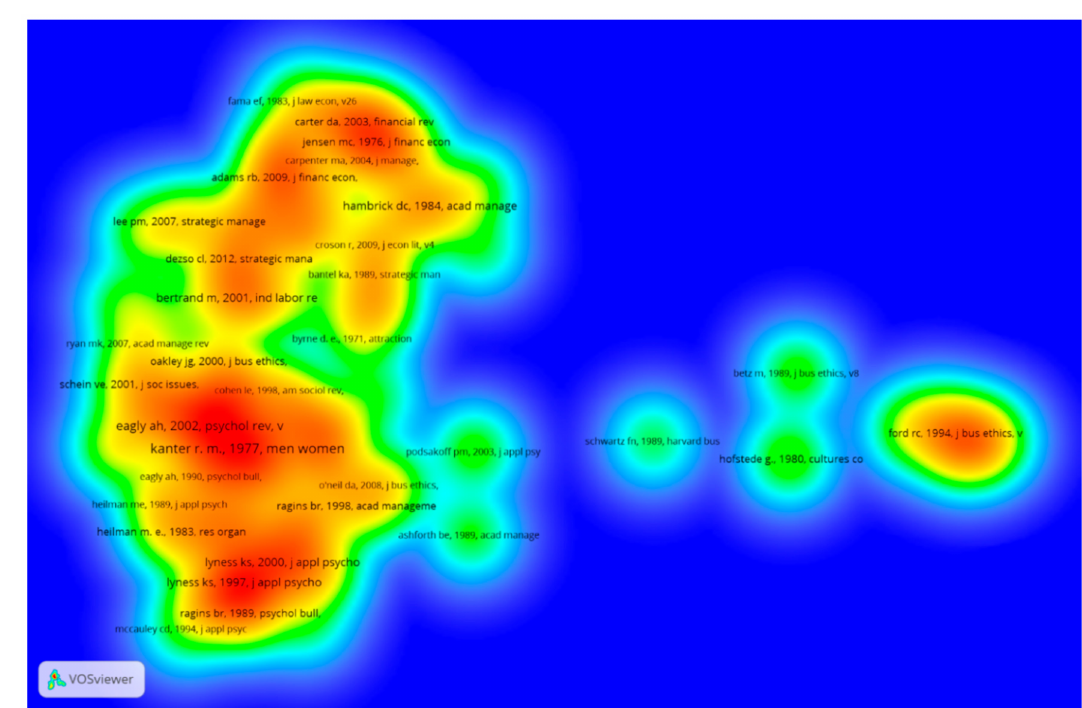
Figure 8. Bibliometric density map (co-cites). Source: Prepared by the authors. As for cluster 1, authors, such as [24,33,34] and other authors, have focused on